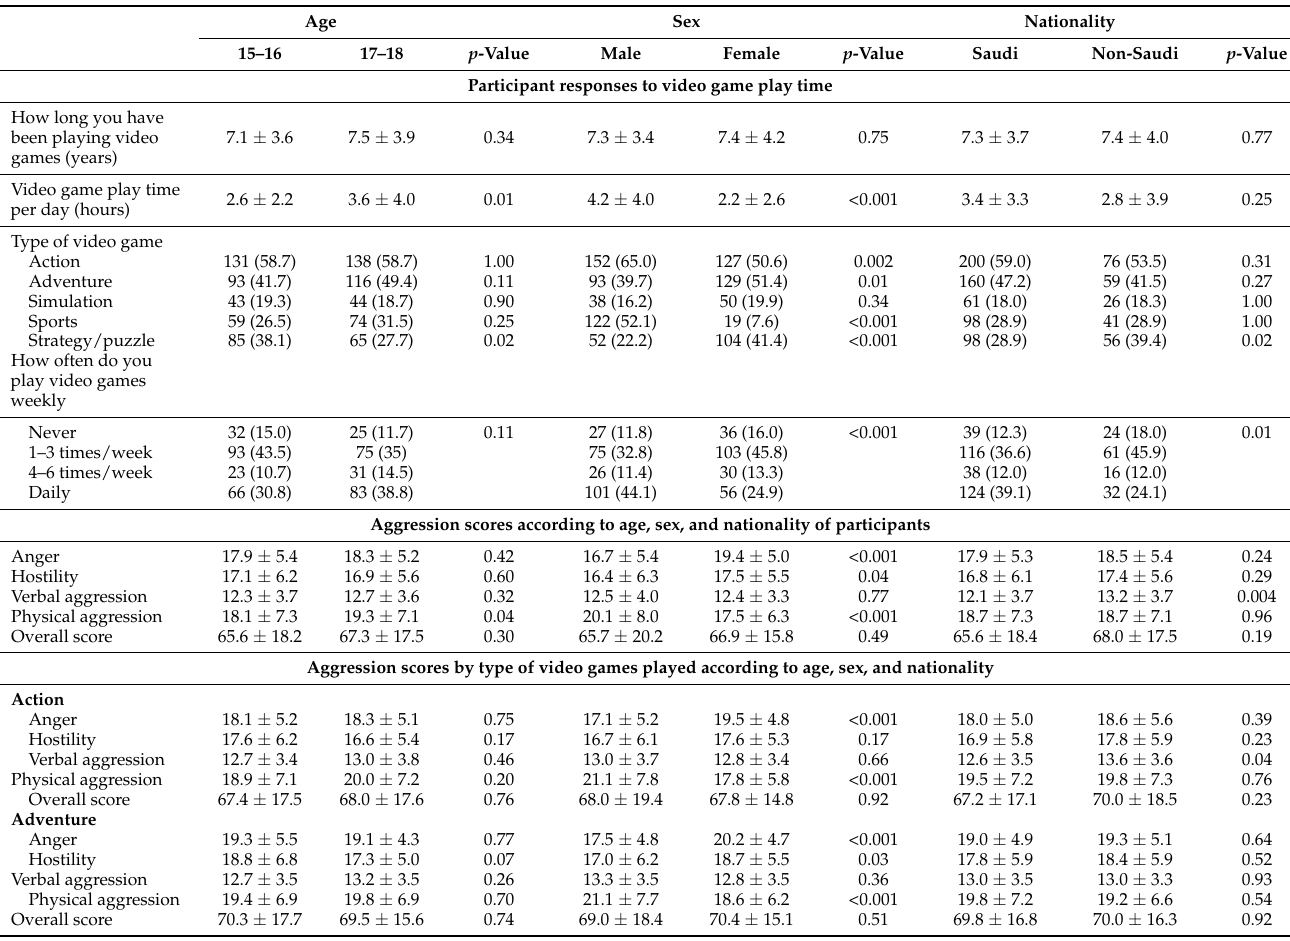
Table 3. Participant responses by age, sex, nationality, and types of video game